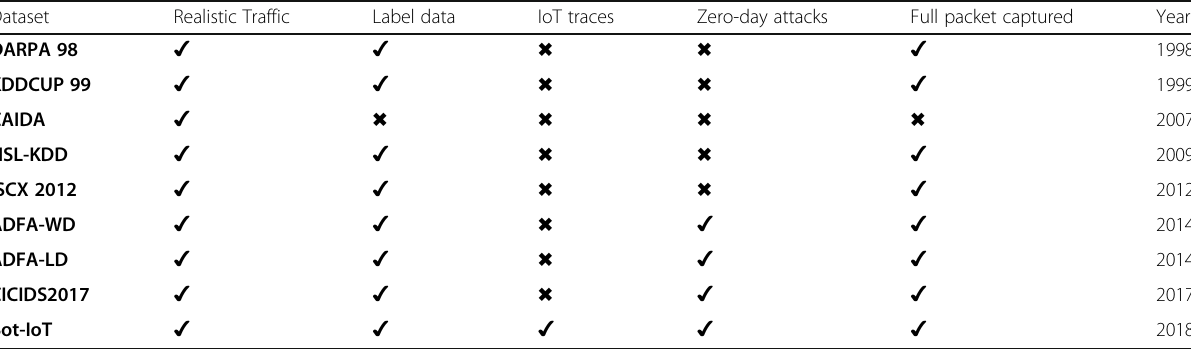
Table 13 Compassion of datasets ( ✔ = True, ✖ = False)